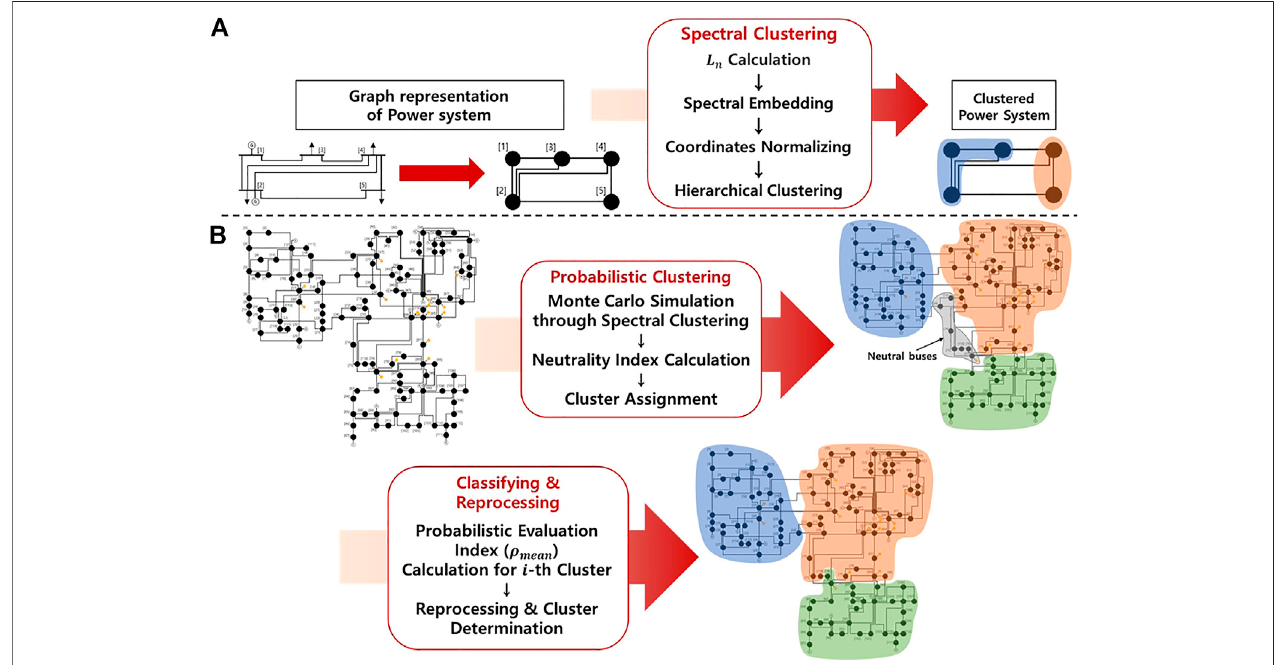
FIGURE 1 | Clustering process. (A) Hierarchical spectral clustering method. (B) Probabilistic spectral clustering and classi fi cation of neutral buses.